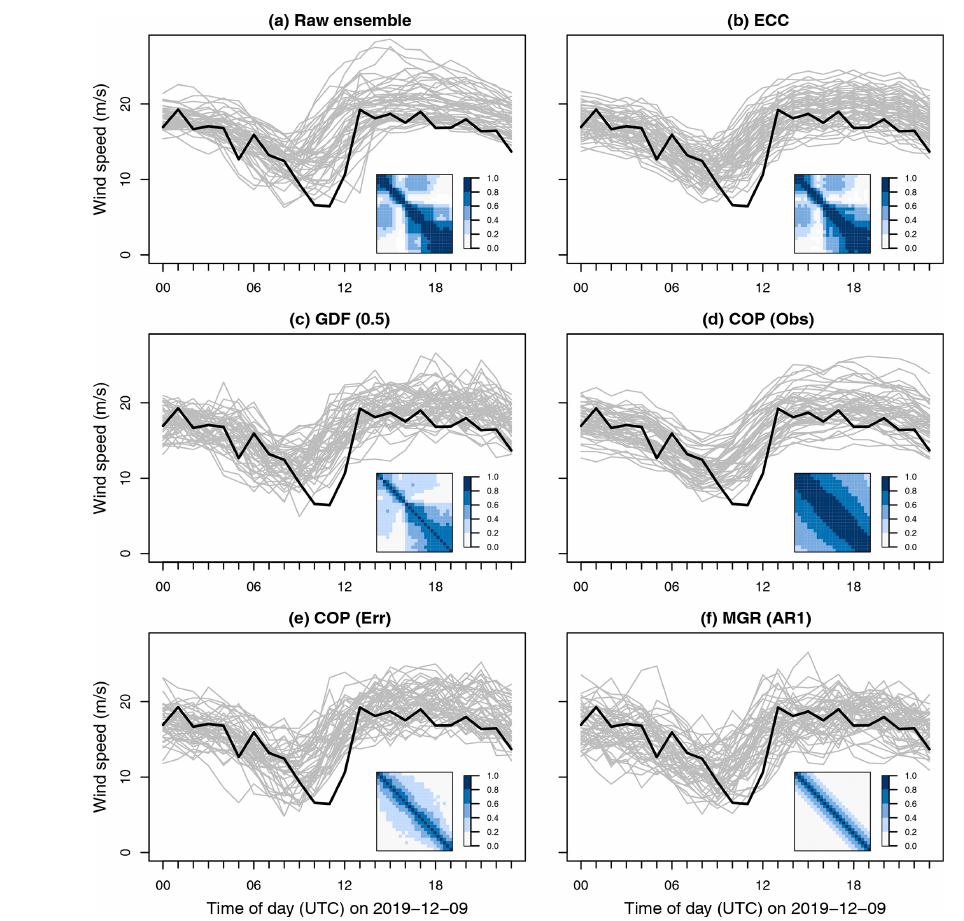
Figure 1. Wind speed ensembles at FINO1 forecasted for the next day ( + 24 to + 47h) with different postprocessing methods. Forecast members are shown as grey lines, and the observations are in black. Where joint distributions are forecasted (c–f) , only 50 simulated members are shown for readability. Also included are sample correlations of the ensembles (a, b) or the correlations of the joint distributions from which members are simulated (c–f) .